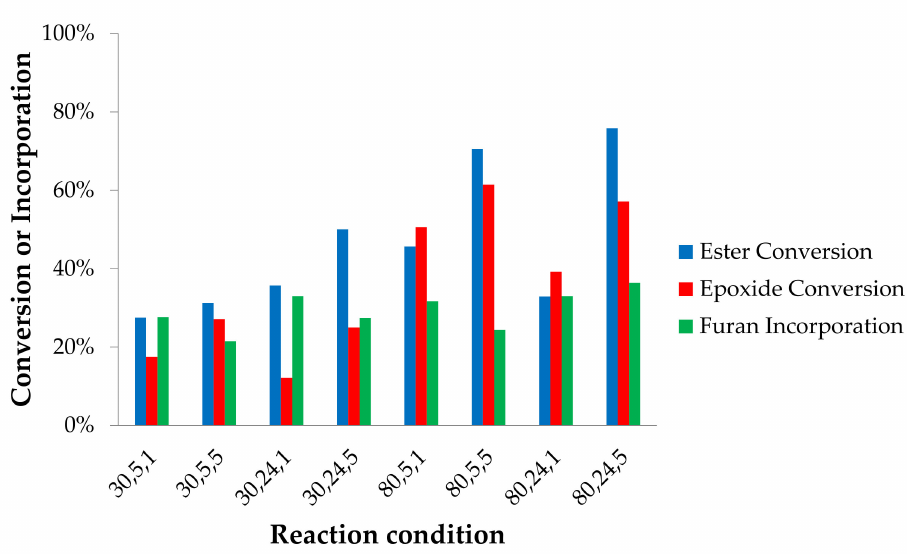
Figure 4. Ester and epoxide conversion, and average amount of furan attachment of the reactions without catalyst. The x-axis indicates reaction conditions: temperature ( ◦ C), time (h), and molar ratio of furfurylamine to